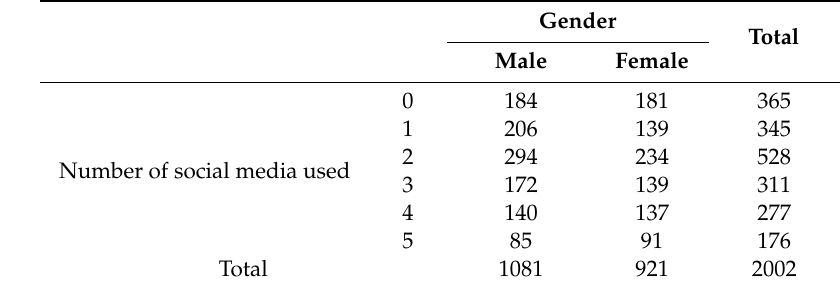
Table 2. Number of social media used by gender.